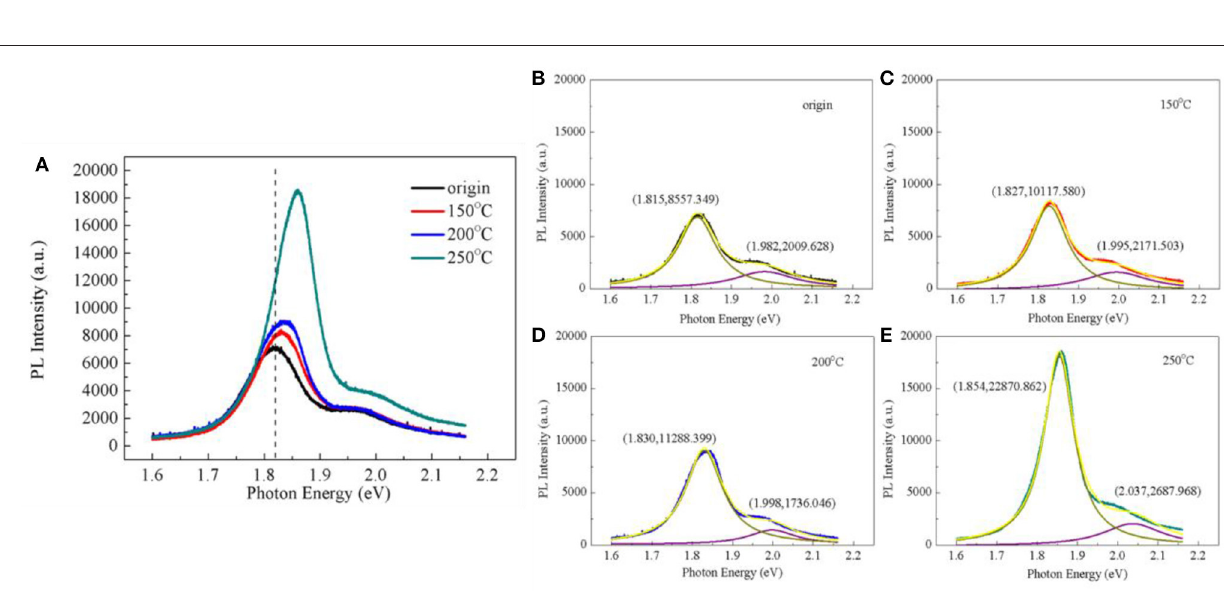
FIGURE 5 | (A) Photoluminescence (PL) spectra of the monolayer MoS 2 film before and after baking at different temperatures. PL peak fitting spectra of the original sample (B) and after baking at 150 ◦ C (C) , 200 ◦ C (D) , and 250 ◦ C (E) .